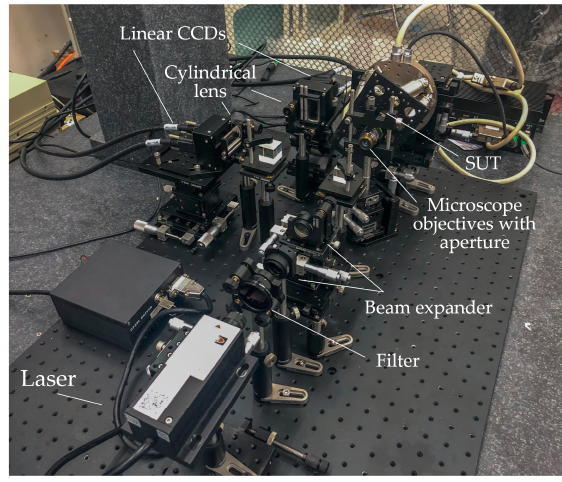
Figure 10. Experimental setup for the measurement system proposed in this study. The data (2°, 10°) of linear CCD1 and linear CCD2 (7°, 5°) data were normalized and compared with the simulation model. The comparison outcomes are displayed in Figure 11. Moreover, a screenshot of the software integrated with the line array CCD is also pro- vided.